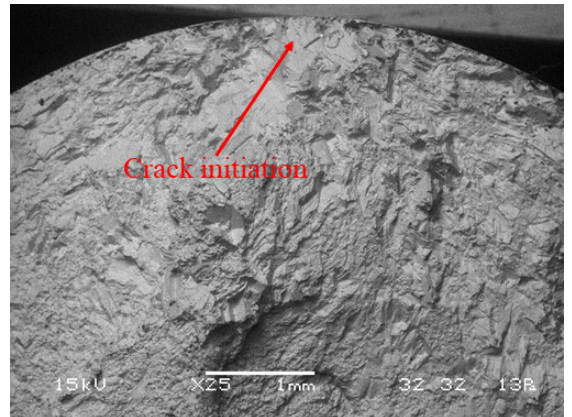
Figure 13. Crack initiation site for a specimen extracted from Bar B